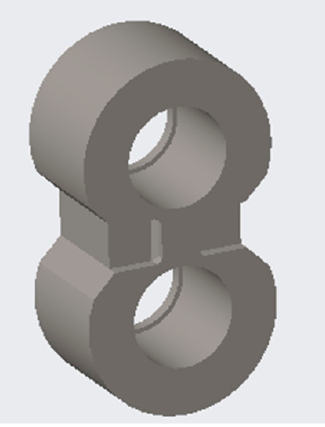
Figure 5. Shim view.